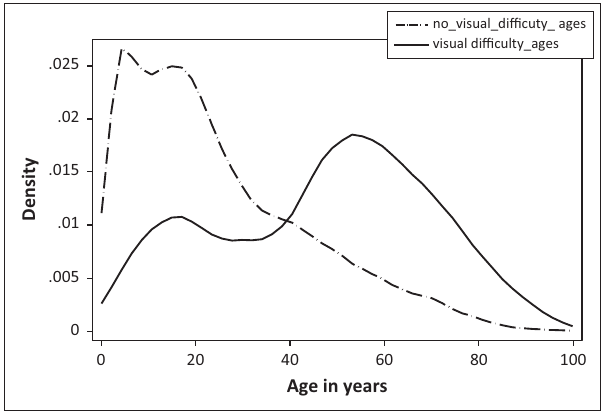
FIGURE 5: Comparisons between ages for those with self-reported vision difficulties and those without vision